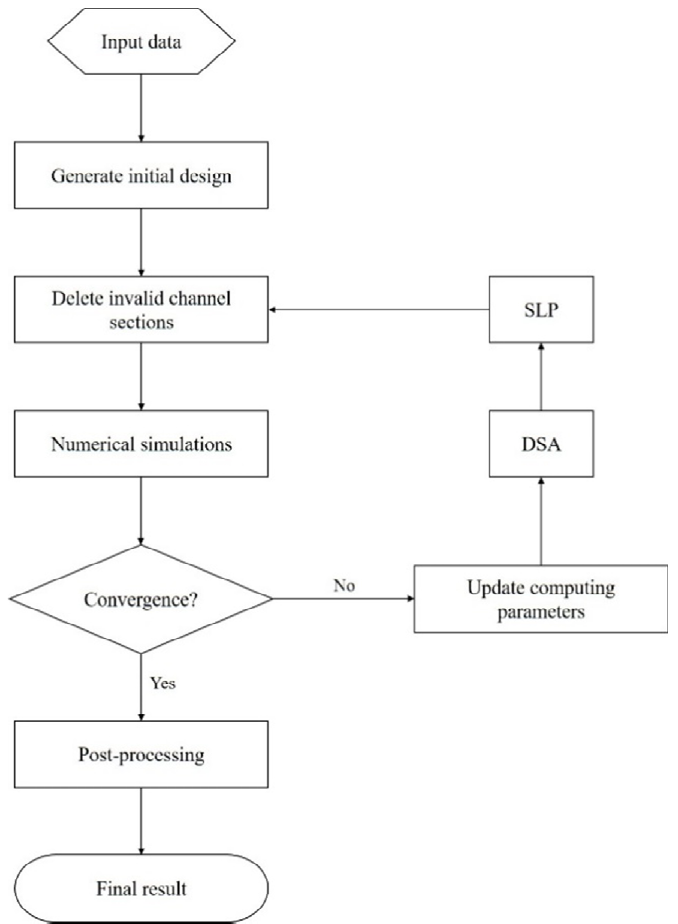
Figure 10. Flowchart of the optimization process implemented by Li et al. [36]. Adapted with permission from [36], 2017, Li et al. [36].